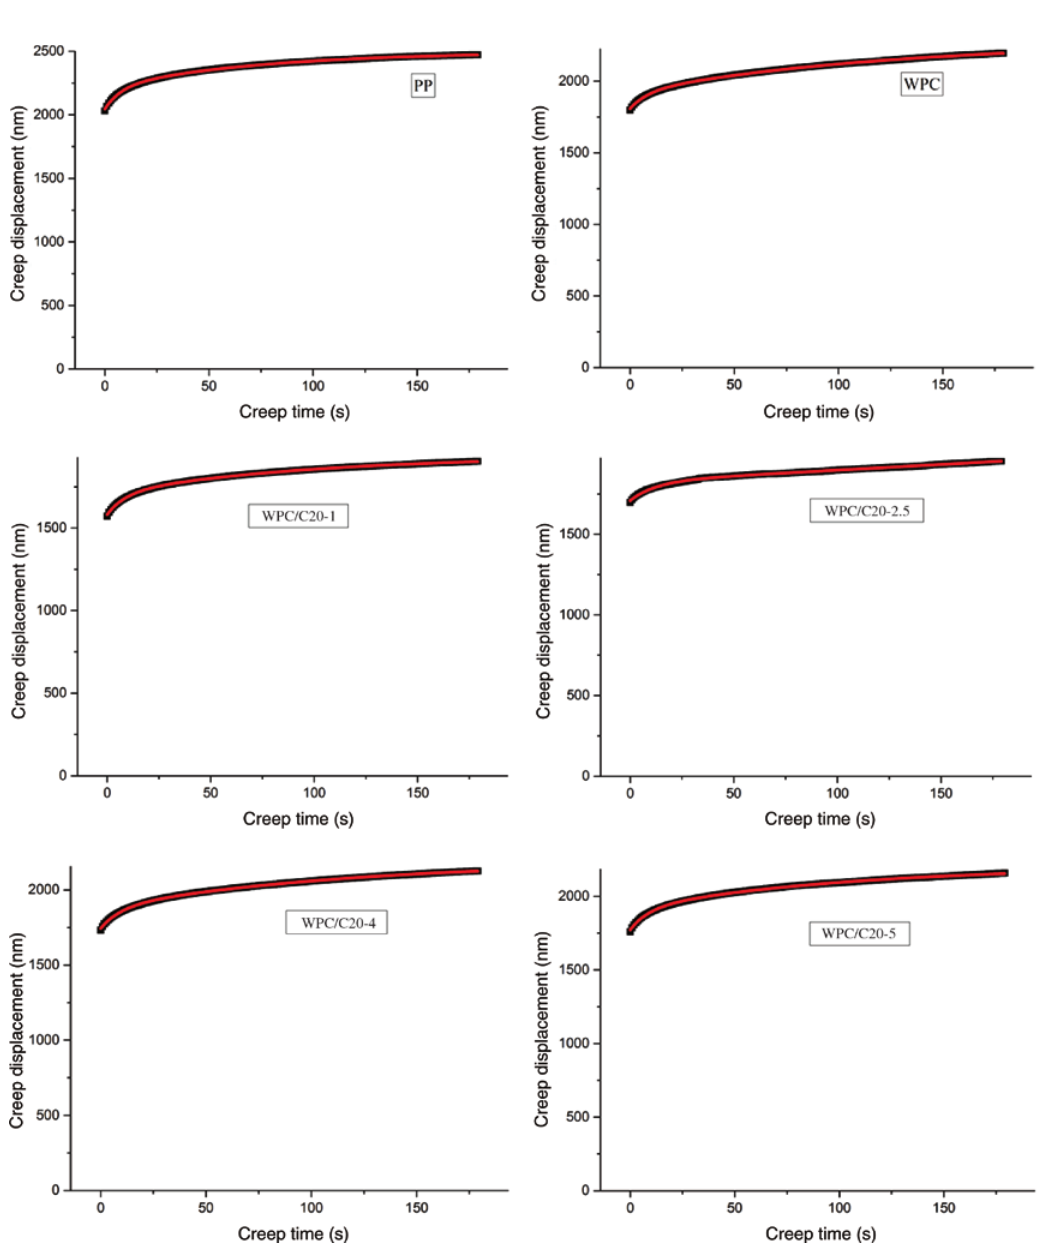
Figure 4: Creep versus time for PP, WPC and WPC/C20 with different nanoclay concentrations. The solid black line is experimental data and the thin red line is fitting results by Equation